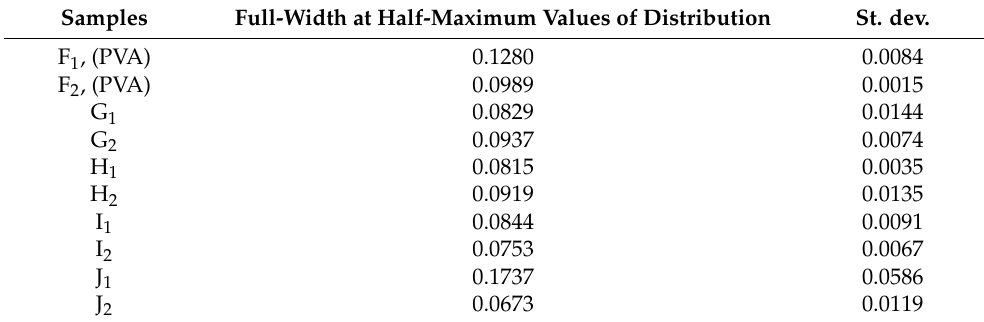
Table 3. The full-width at half-maximum values of fiber diameter distribution (a supplement of Figure 3). Samples Full-Width at Half-Maximum Values of Distribution St. dev.